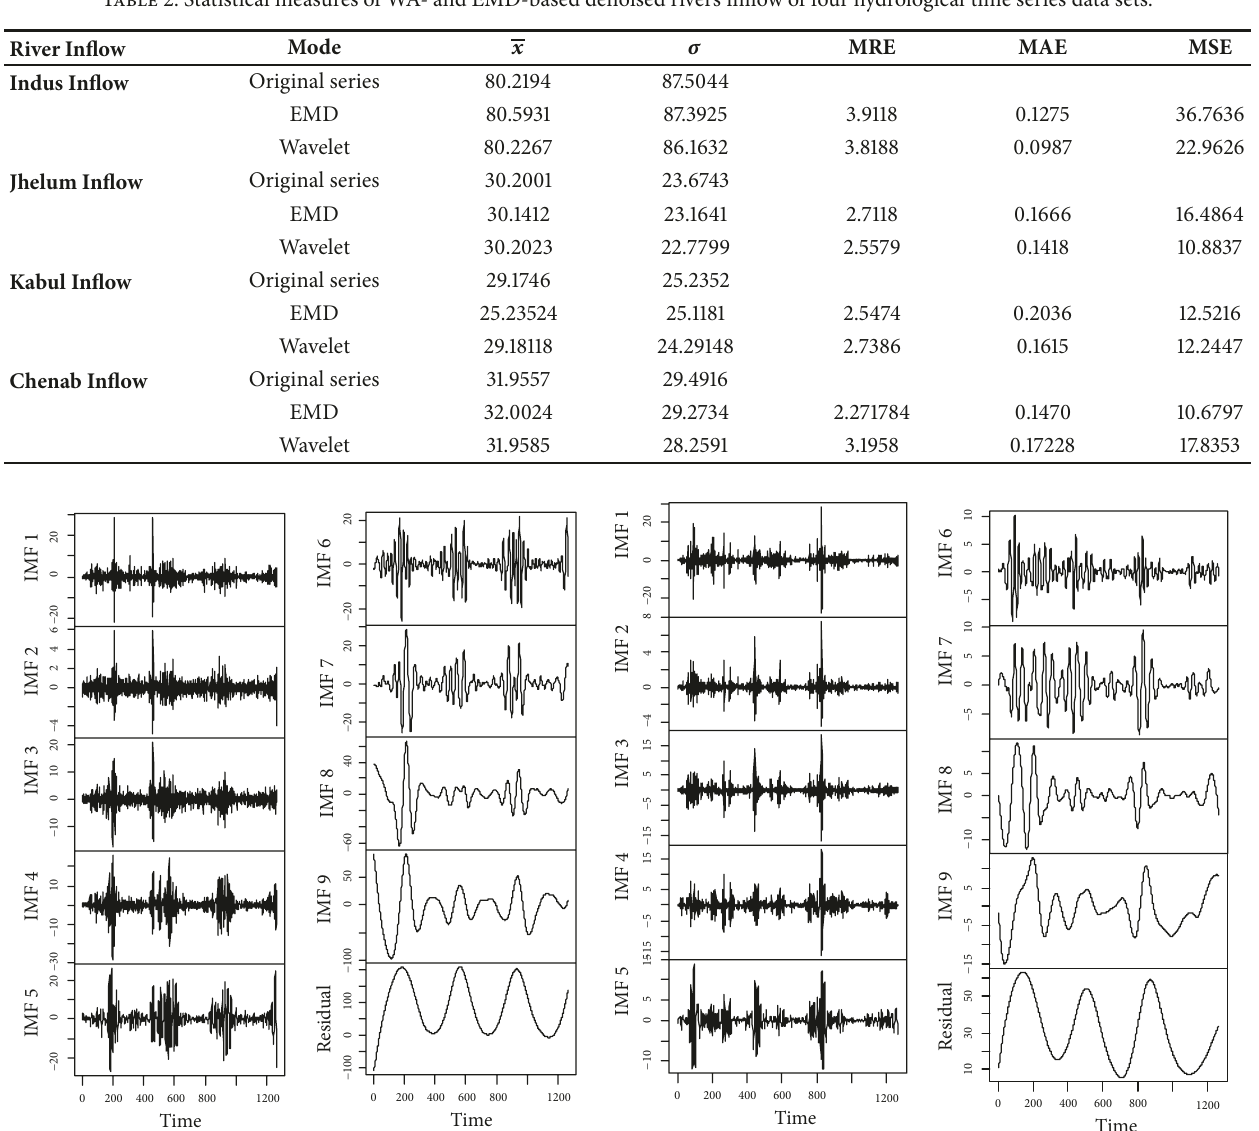
Figure 6: The EMD-CEEMDAN decomposition of Indus (left) and Jhelum rivers inflow (right). The two series are decomposed into nine IMFs and one